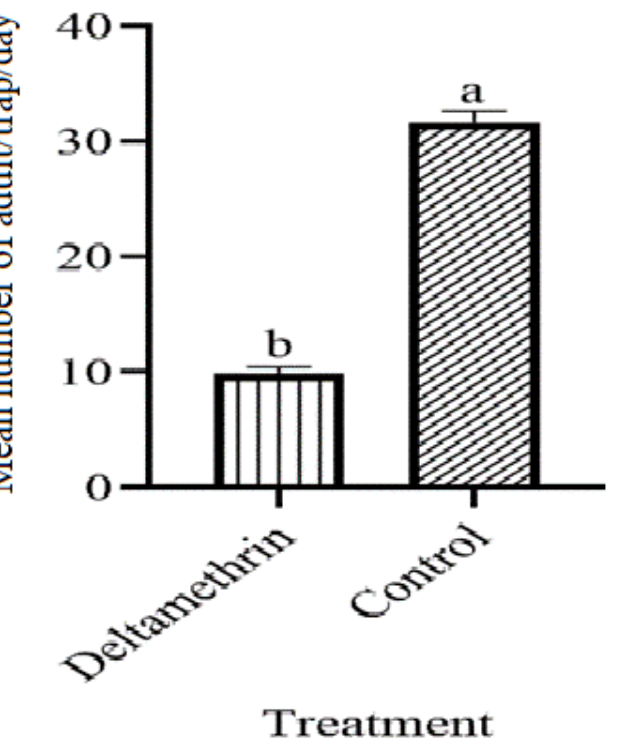
Figure 7. Adults’ collection of A. aegypti after lethal ovitraps installation. These letter shows significant difference among treatments.